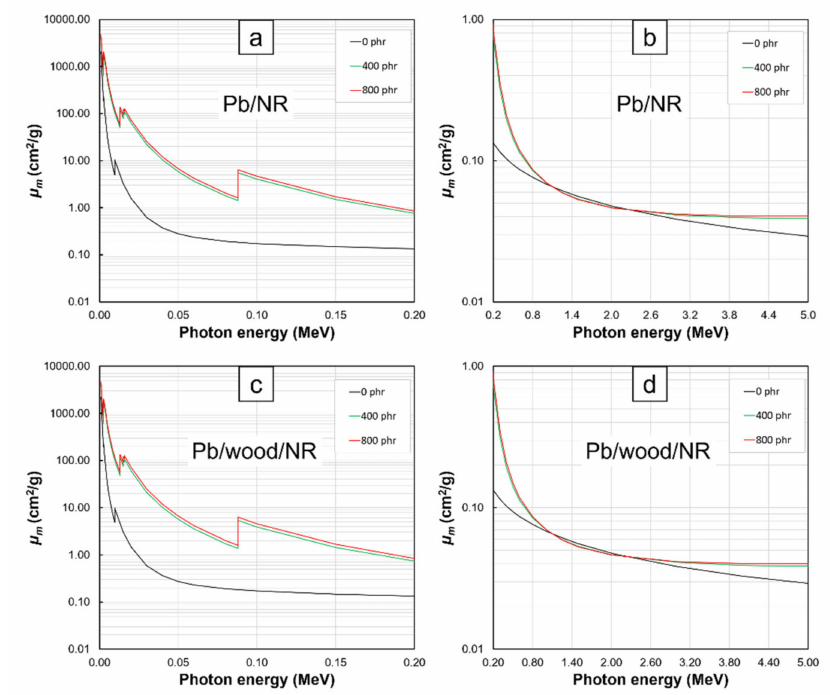
Figure 3. µ m values of ( a , b ) Pb/NR and ( c , d ) Pb/wood/NR composites with filler contents of 0, 400, and 800 phr, determined at photon energies of ( a , c ) 0.001–0.2 MeV and ( b , d ) 0.2–5 MeV using XCOM. Raw data are provided in the Supplementary Materials (Tables S1, S4, S5, S8, S11, and